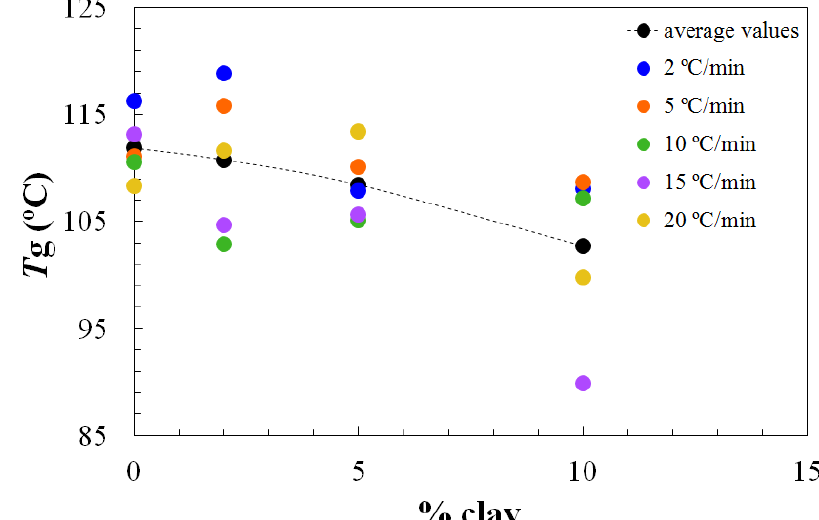
Figure 7. The dependence of the glass transition temperature of the fully cured samples, T , on clay content for the non-isothermal cure. The black dotted line represents the g ∞ average value for each percent of clay